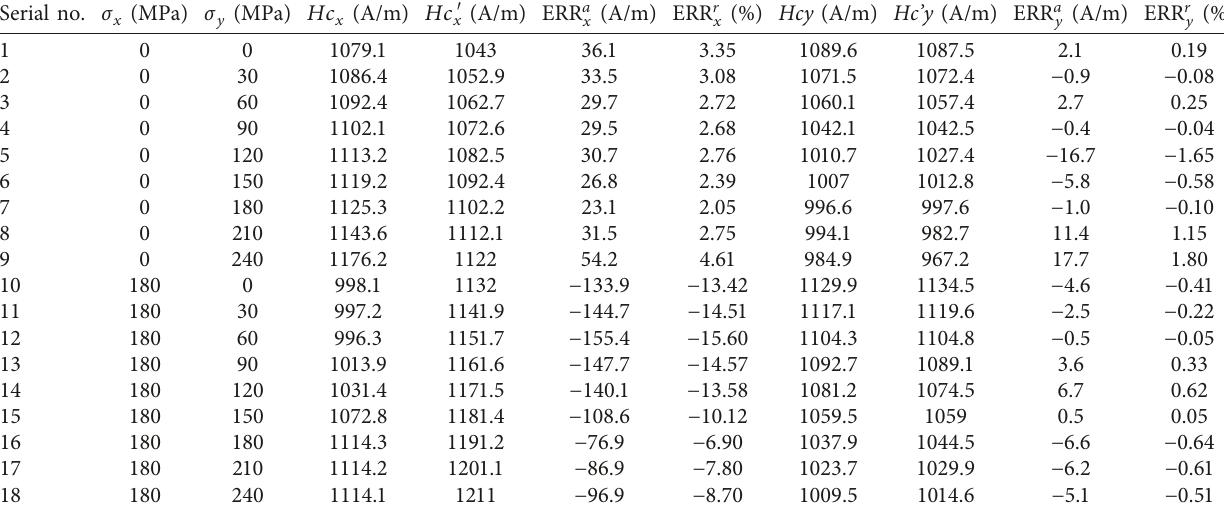
Table 4: Error analysis of fitting results of test piece 2.